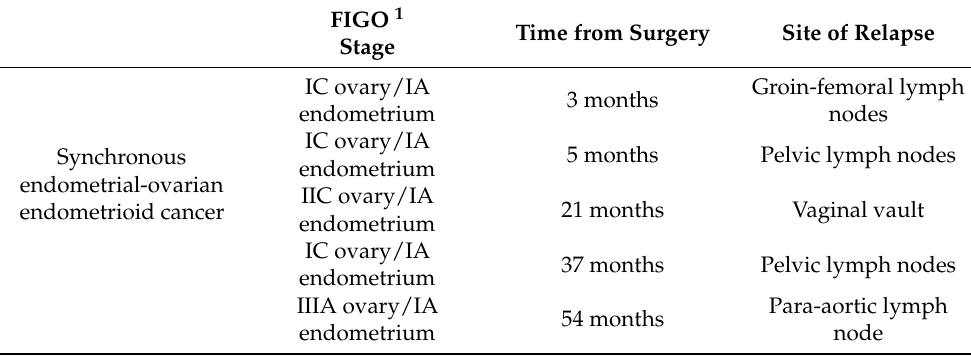
1 FIGO: International Federation of Gynecology and Obstetrics (old classification